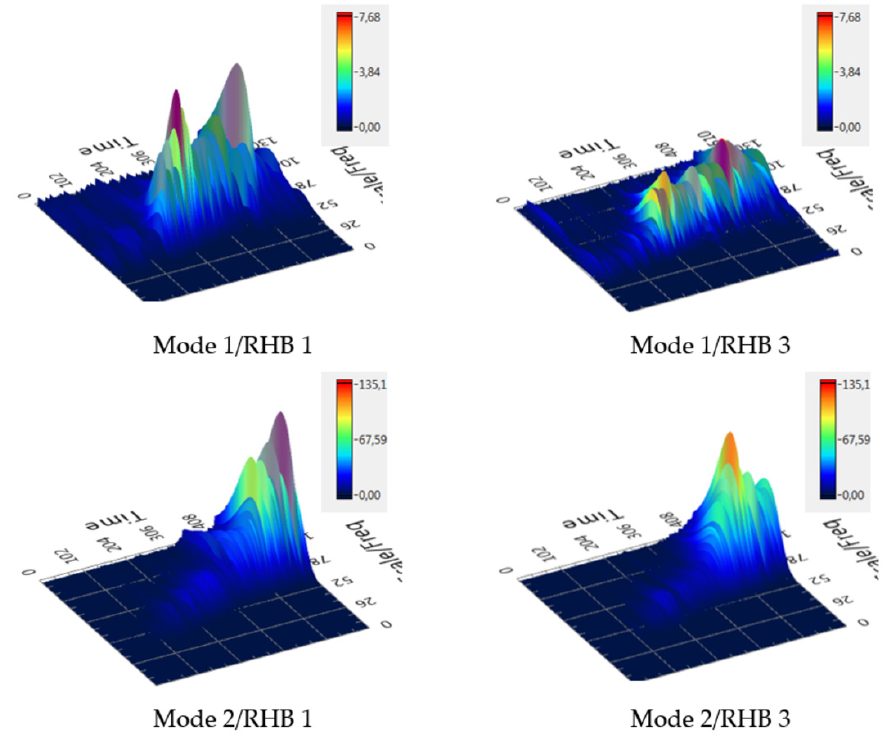
Figure 6. Wavelet transform in 3D view, frequency (Hz), time (s), and amplitude (g). By comparing the wavelet transform graphs for low and high vibration amplitude excitation of RHBs 1 and 3, i.e., without and with the damping mass, a much “calmer” response (lower amplitudes) can be observed in the case of RHB 3 with damping material